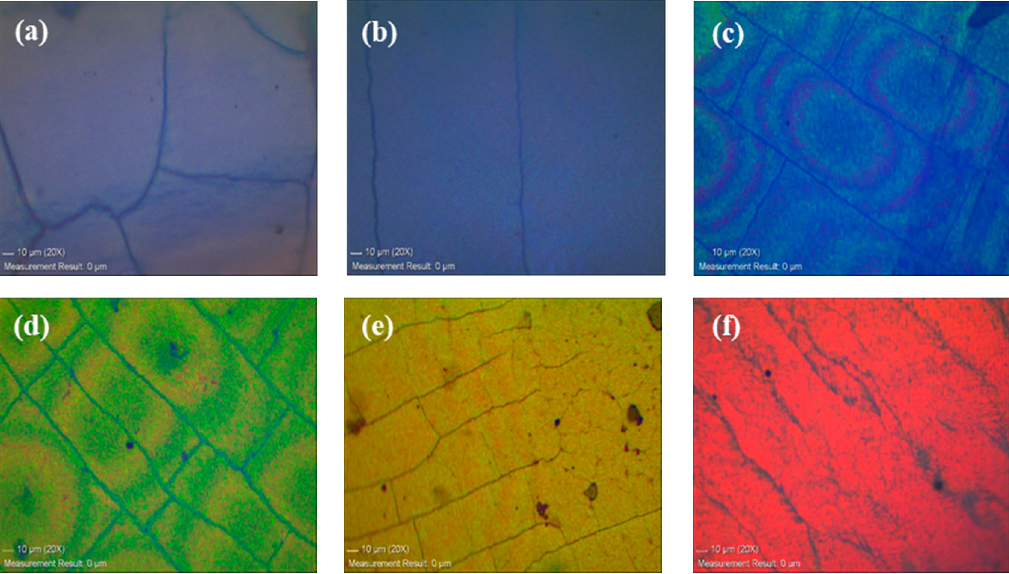
Figure 6. Optical micrographs of PC films consisting of SiO 2 spheres with dimensions of: ( a ) 181; ( b ) 199; ( c ) 231; ( d ) 242; ( e ) 271; and ( f ) 310 nm.